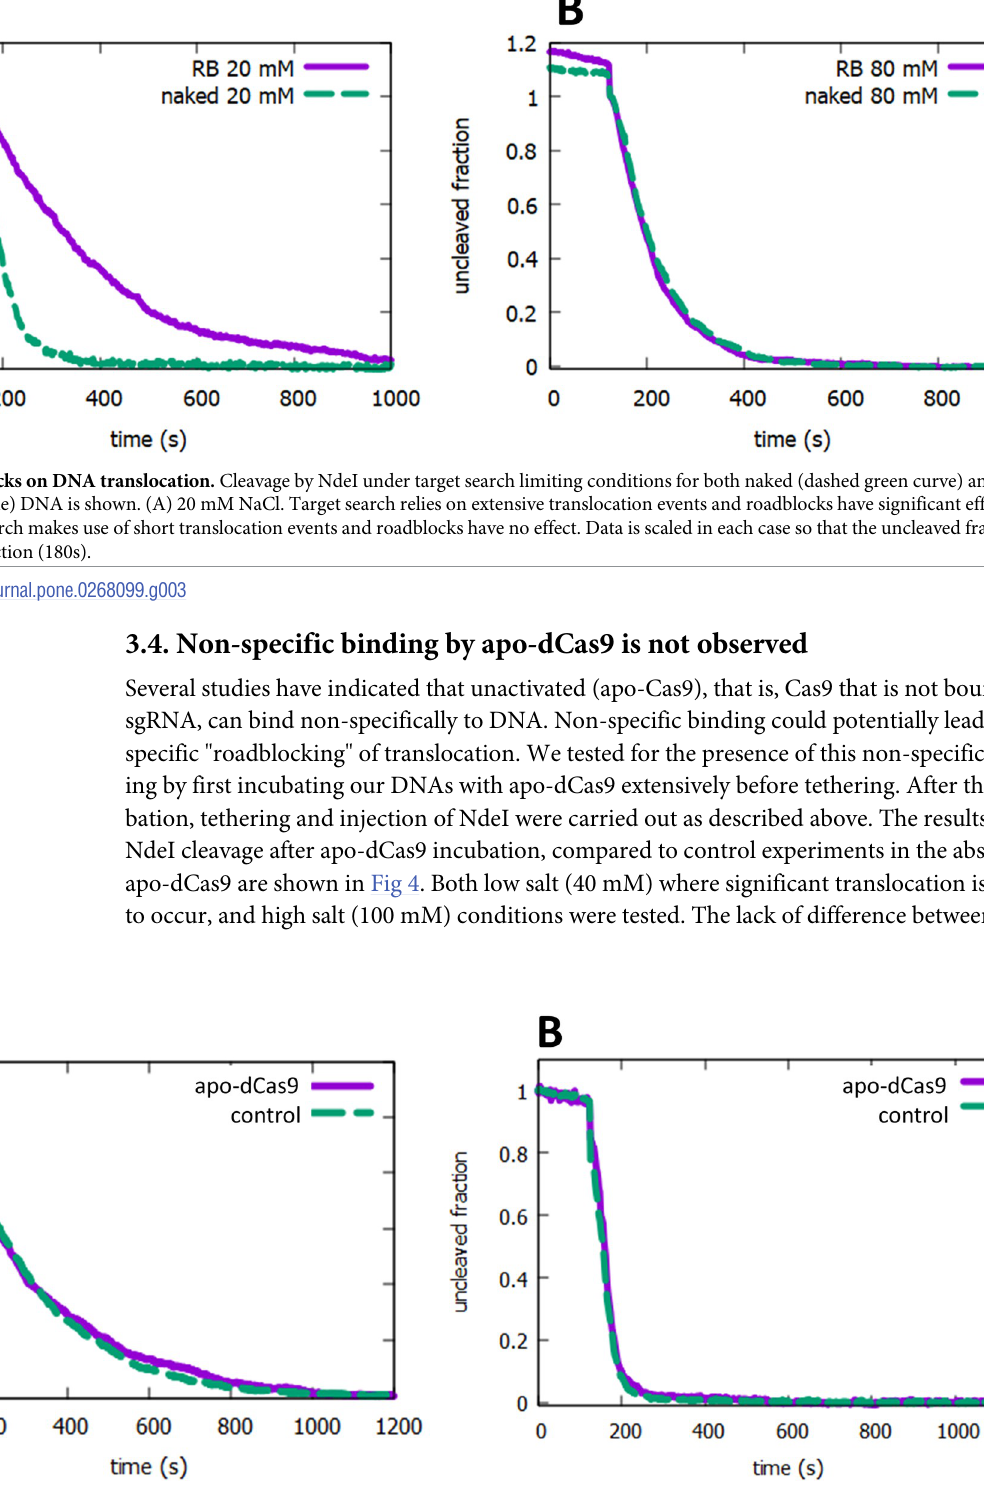
Fig 4. Non-specific binding by apo-dCas9 is not observed. Cleavage by NdeI under target search limiting conditions with both naked (control, dashed green curve) and DNA incubated with apo-dCas9 (apo-dCas9, purple solid curve) is shown. (A) 40 mM NaCl. (B) 100 mM NaCl.